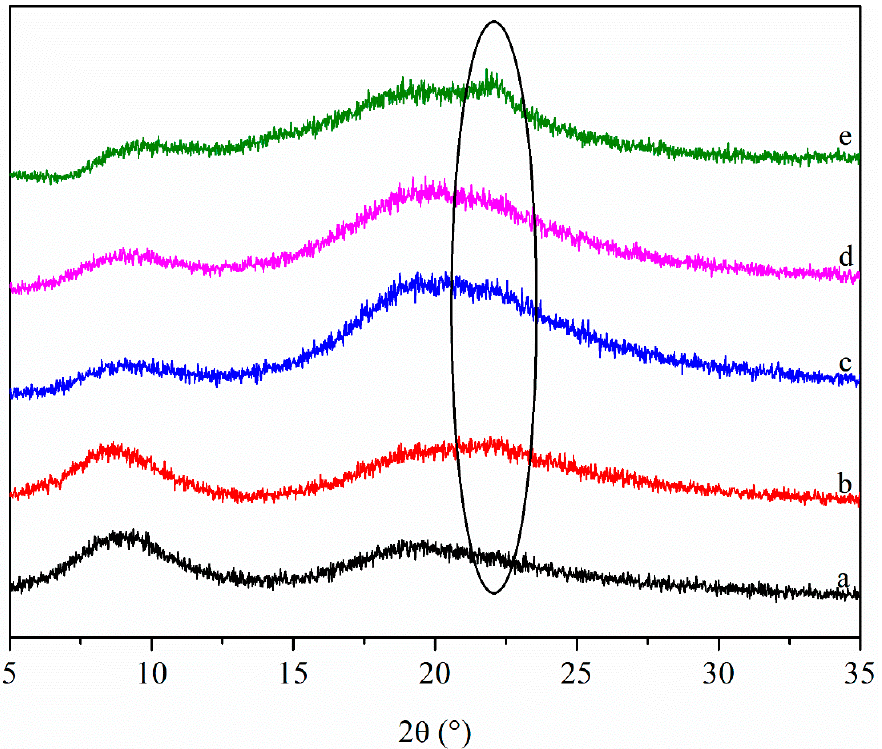
Figure 3. XRD patterns of Zein/NPs ( a ), Zein/NPs/2CNCs ( b ), Zein/NPs/4CNCs ( c ), Zein/NPs/6CNCs ( d ) and Zein/NPs/8CNCs ( e ).